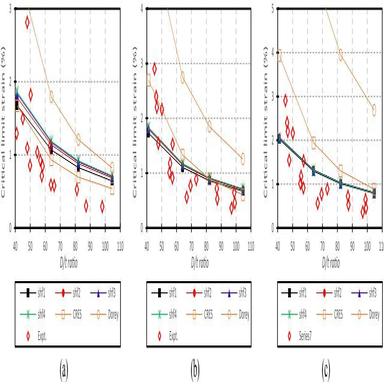
Comparison of CLS models with experimental test results for RHT X60 pipe. (a) fp = 0.0, (b) fp = 0.4, and (c) fp = 0.8.